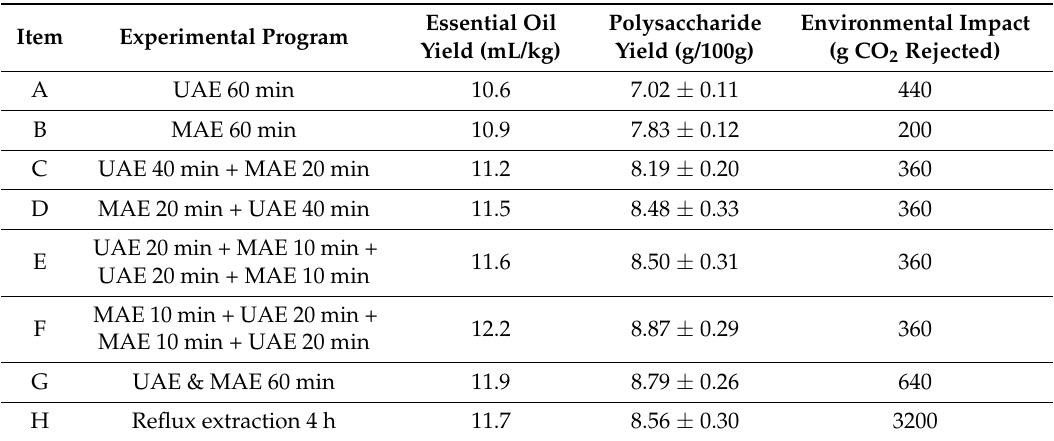
Table 3. Experimental program of alternating ultrasound/microwave extractions of polysaccharides. Essential Item Experimental Program